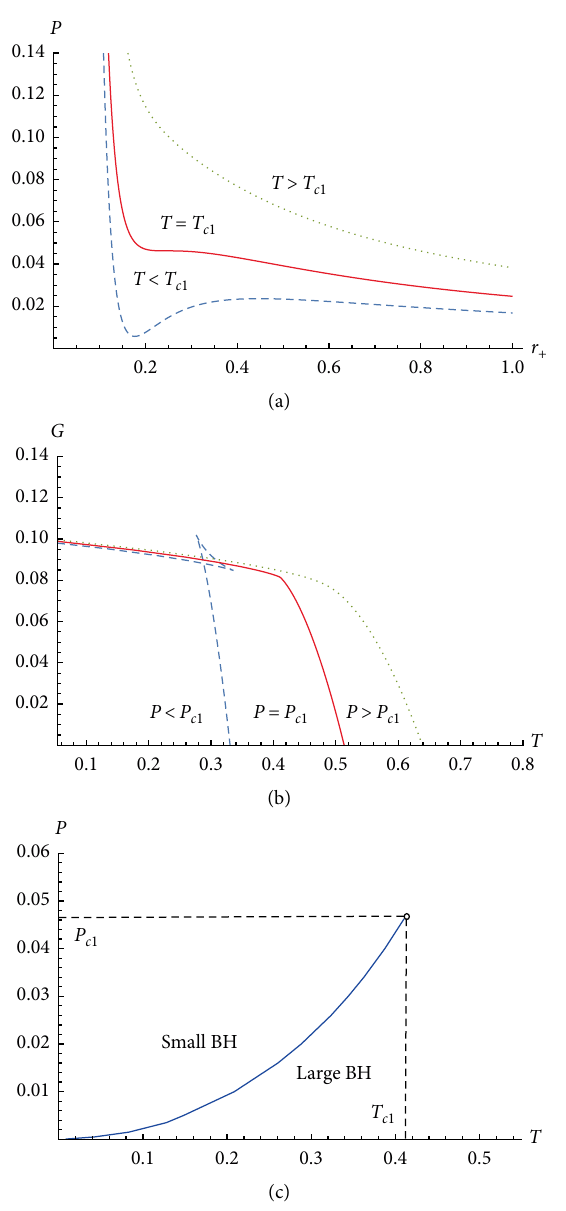
Figure 2: The 𝑃 − 𝑟 , 𝐺 − 𝑇 , and 𝑃 − 𝑇 diagrams of four- + dimensional charged AdS black holes with 휔 = 0 , 휉 = − 0.8 , 푄 = 0.1 𝑑 , and 푁 = 0.1 . There is one critical point, which corresponds to 𝑑 VdW-like SBH/LBH phase transition when 푇 < 푇 ≈ 0.4104 and 푐1 푃 < 푃 ≈ 0.0463 . 푐1